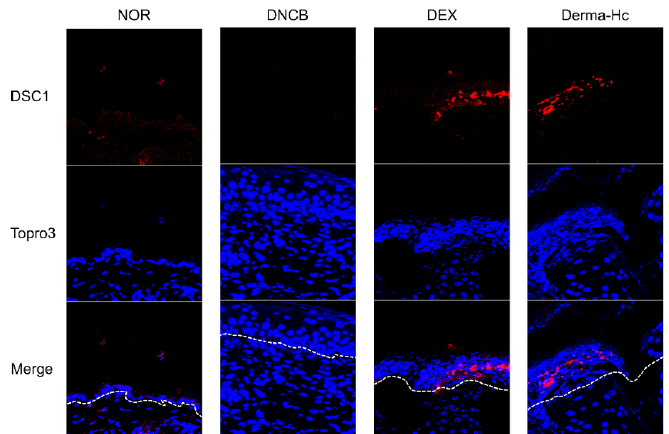
Figure 5. Derma-Hc up-regulates the expression level of DSC1 in DNCB-induced mice. NOR, Normal saline-treated group; DNCB, 2,4-dinitrochlorobenzene (DNCB)-sensitized group; DEX, DNCB-sensitized and dexamethasone-treated group. The pattern of DSC1 was detected by immu- nofluorescence analysis. Nuclei (blue) was stained with TO-PRO-3. DSC1 (red) was expressed in the layer of stratum granulosum and stratum spinosum in epidermis.